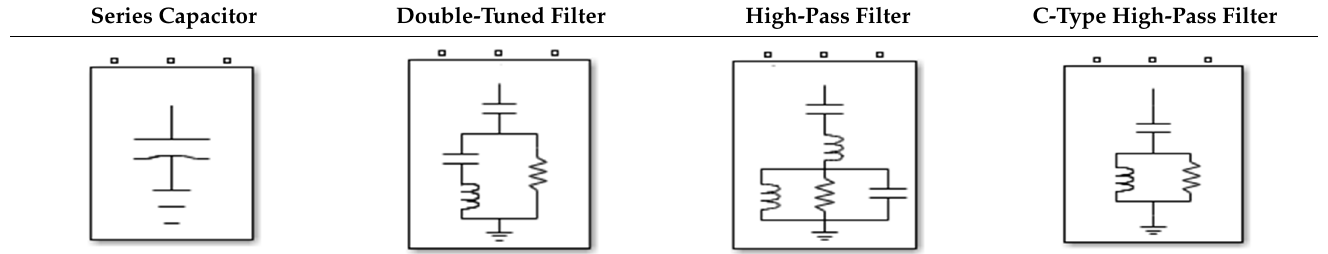
Table 2. Different types of filter configurations used as harmonic filters, used as a single filter or in combination, each having a nominal line-to-line voltage of 500 kV, and 50 Hz with a nominal reactive power var is 150 Mvar.